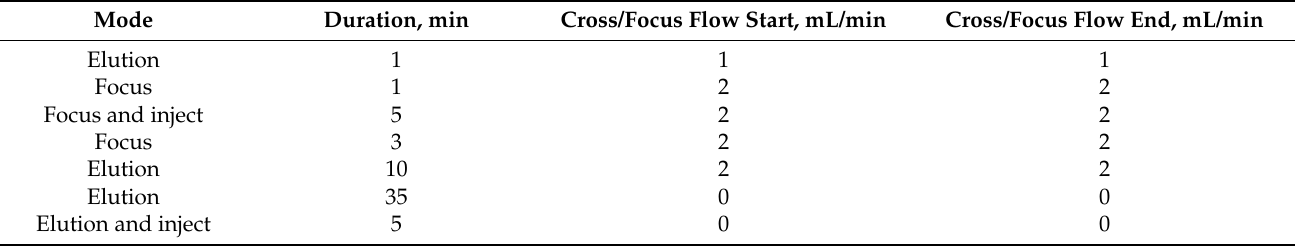
Table 1. Asymmetrical flow field-flow fractionation (AF4) separation conditions applied in the release experiments. The injection and detector flow were set to 0.2 mL/min and 1 mL/min, respectively.